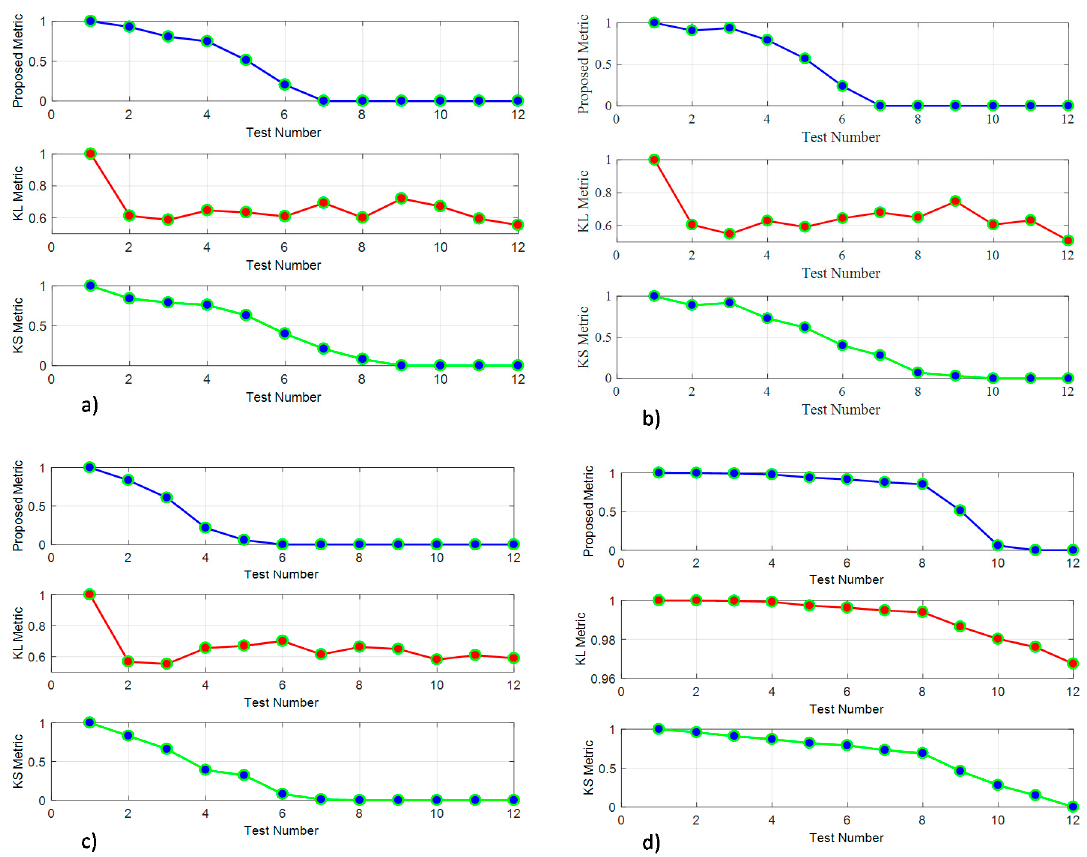
Figure 6. The results of the three metrics calculated based on: ( a ) changing the shape parameter of a gamma distribution; ( b ) changing the scale parameter of a gamma distribution; ( c ) changing the shape and scale parameters of gamma distribution; ( d ) linearly shifting the distribution.